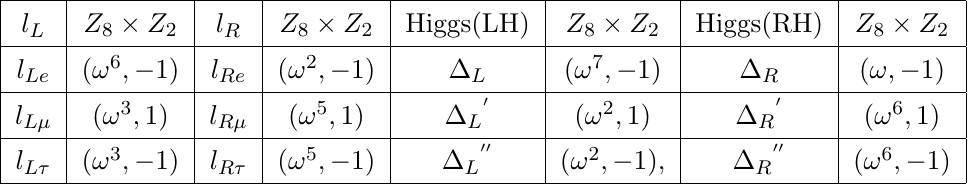
Table 2 . Particle assignments for A2.